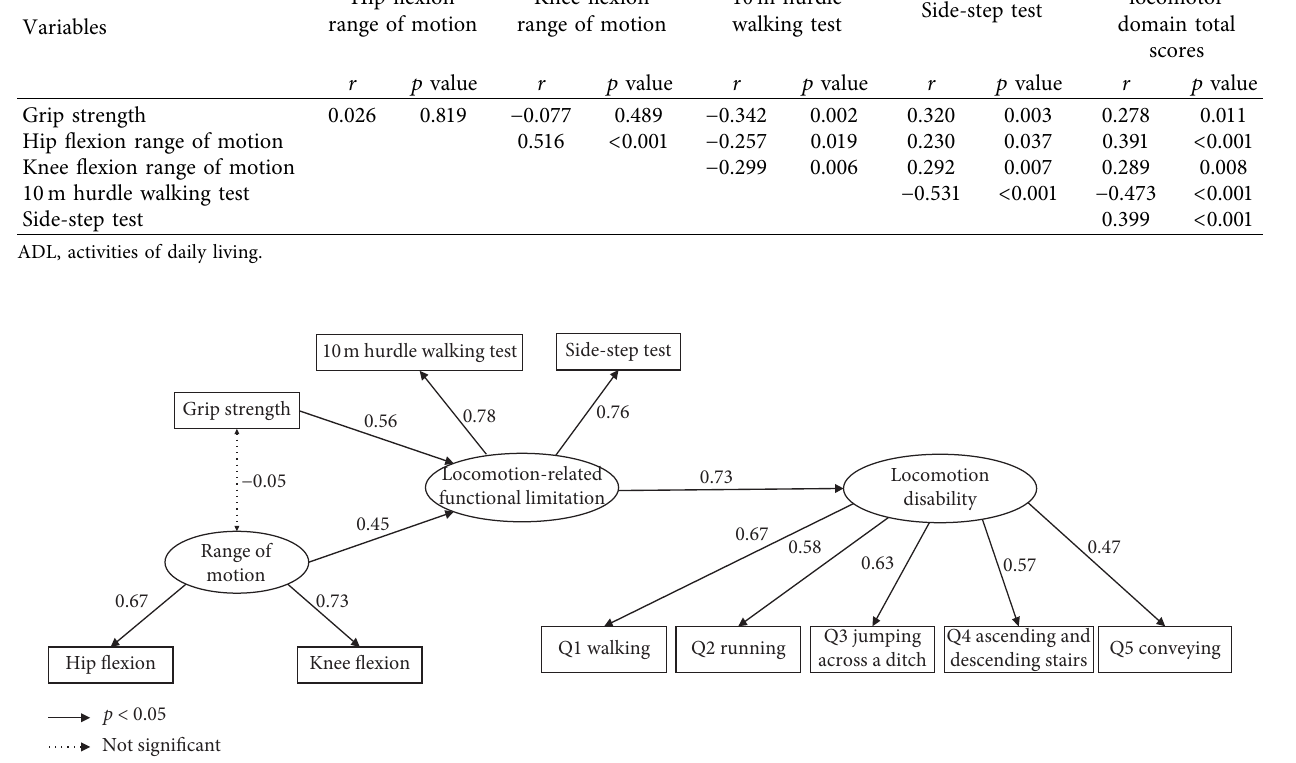
Figure 2: Result of path analysis for the hypothetical